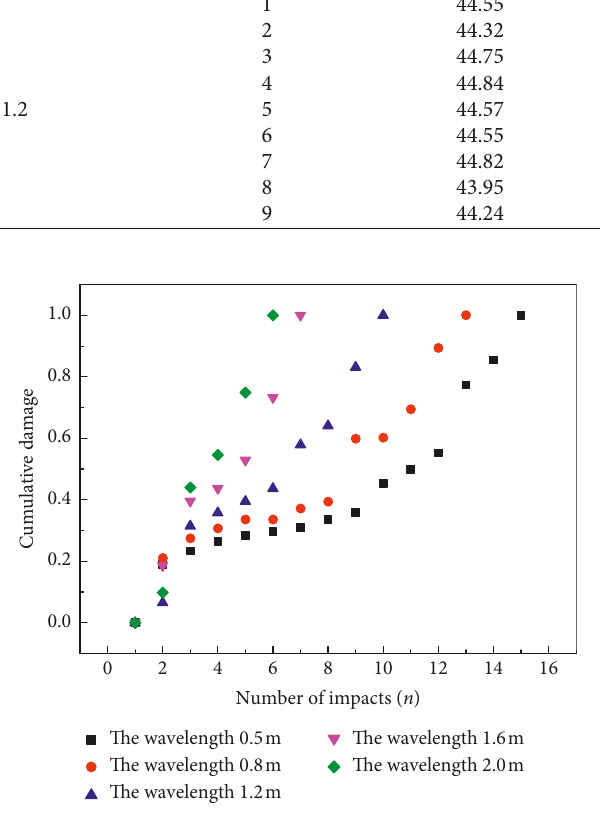
Figure 5: Damage evolution of siltstone under cyclical impact.